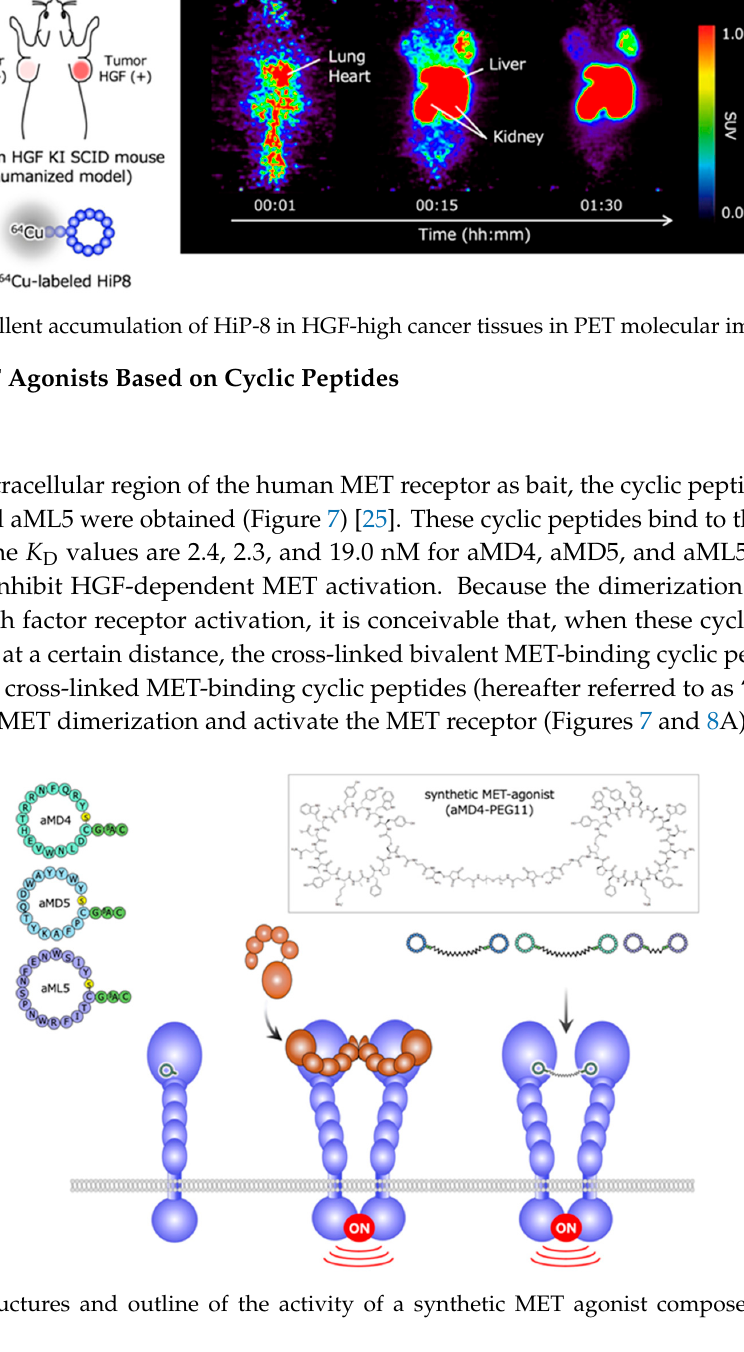
Figure 8. MET receptor activation ( A ), the promotion of cell motility ( B ), and the induction of tubulogenesis ( C ) by HGF and synthetic MET agonists by cyclic peptides [25]. The MET activation, cell motility, and tubulogenesis were analyzed using human mesothelioma cells ( A ) or normal human renal tubular cells ( B , C ). Scale bar, 400 μ m. 4.2. MET Activation and Biological Activities The maximal activities for MET activation by these bivalent MET-binding cyclic peptides are comparable to the maximal activity of HGF protein, while the concentrations of the synthetic MET agonists needed to induce maximal MET activation are 20–40 times higher than those of HGF protein [25]. MET activation results in different biological activities depending on the cell type and context. Synthetic MET agonists promote the motility and proliferation of cells, and induce tubulogenesis by epithelial cells when cells are in a 3D collagen matrix (Figure 8B,C). The biological activities of synthetic MET agonists showed activities comparable to those of HGF in different assays. The investigation of the activation profiles for intracellular signaling molecules downstream of MET, such as Erk and Akt, and their changes in the gene expression profile upon MET activation indicate that the synthetic MET agonist induces the activation of signaling molecules and changes in gene expression profiles, with a potency that is largely indistinguishable from that of HGF protein (Figure 9) [26]. The performance of synthetic MET agonists composed of cyclic peptides indicates that synthetic agonists for growth factor/cytokine receptors; in other words, synthetic growth factors/cytokines are obtainable basically by the same method.